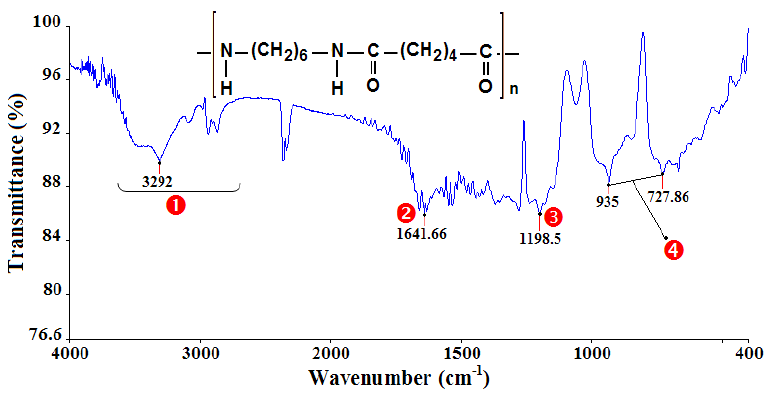
Figure 2. Infrared spectra of